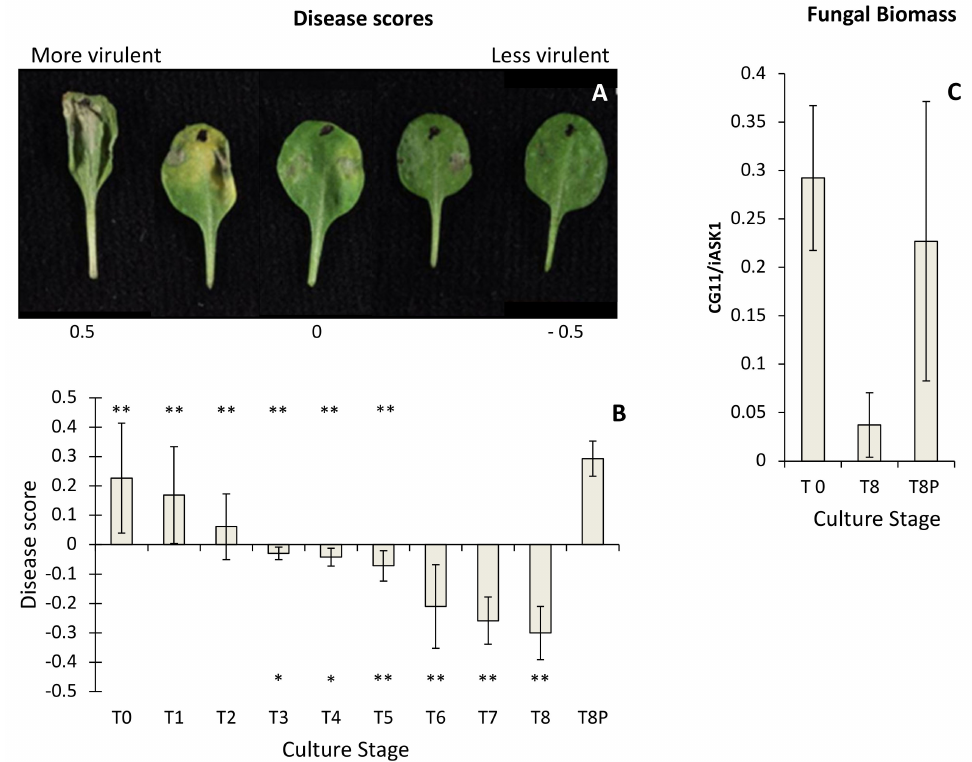
Figure 1. Estimation of Botrytis cinerea virulence on Arabidopsis thaliana . ( A ) Examples of A. thaliana Col-0 leaves drop-inoculated with B. cinerea and presenting disease scores ranging from − 0.5 (low virulence) to 0.5 (high virulence). ( B ) Estimated B. cinerea virulence at each time culture point. Virulence of B. cinerea cultures was estimated over a period of eight months in culture (T0, initial inoculum; T8, eight months in culture) and after 8 months in culture and a single passage on A. thaliana (T8P). A weighted scoring method was used to categorise B. cinerea lesion phenotypes 3 days post- inoculation. Virulence symptoms (water-soaking, chlorosis, and spreading necrosis) were conferred a range of positive scores, and the resistant symptoms (necrosis limited to inoculation site) were given negative scores. Asterisk symbols under the horizontal axis indicate significant differences (* ( t -test; p < 0.05) and ** ( t -test; p < 0.01)) between T0 and the time point over the asterisk. Asterisk symbols over the horizontal axis indicate significant differences (** t -test; p < 0.01) between T8P and the time point under the asterisk. ( C ) Detection of in planta B. cinerea hyphal mass in A. thaliana Col-0 by qPCR, as described by Gachon and Saindrenan, 2004